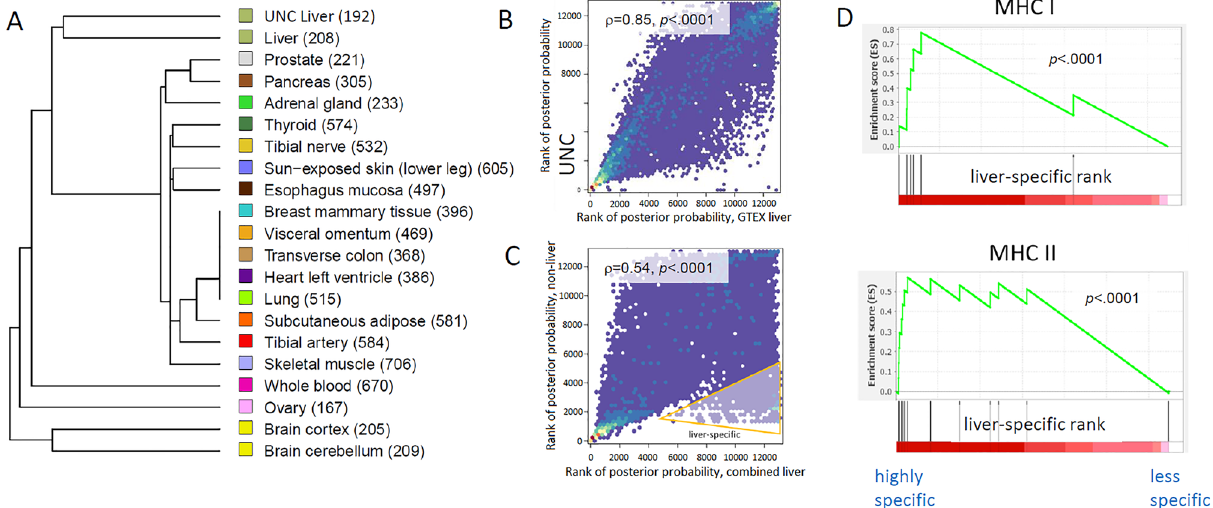
Figure 4. ( A ) Clustering of gene-level eQTL probabilities from the high-tissue Bayesian model shows that the liver studies (UNC and GTEx) are distinct from other GTEx tissues and similar to each other. Color identification scheme is the same as used in 22 . ( B ) UNC liver and GTEx gene-level liver posterior probabilities are highly correlated. ( C ) Comparison of non-liver to combined liver probabilities shows a distinct set of genes that are highly liver-specific for eQTLs. ( D ) GSEA plots: HLA/MHC genes are highly enriched among liver- specific eQTL genes, especially for MHC Class II genes.